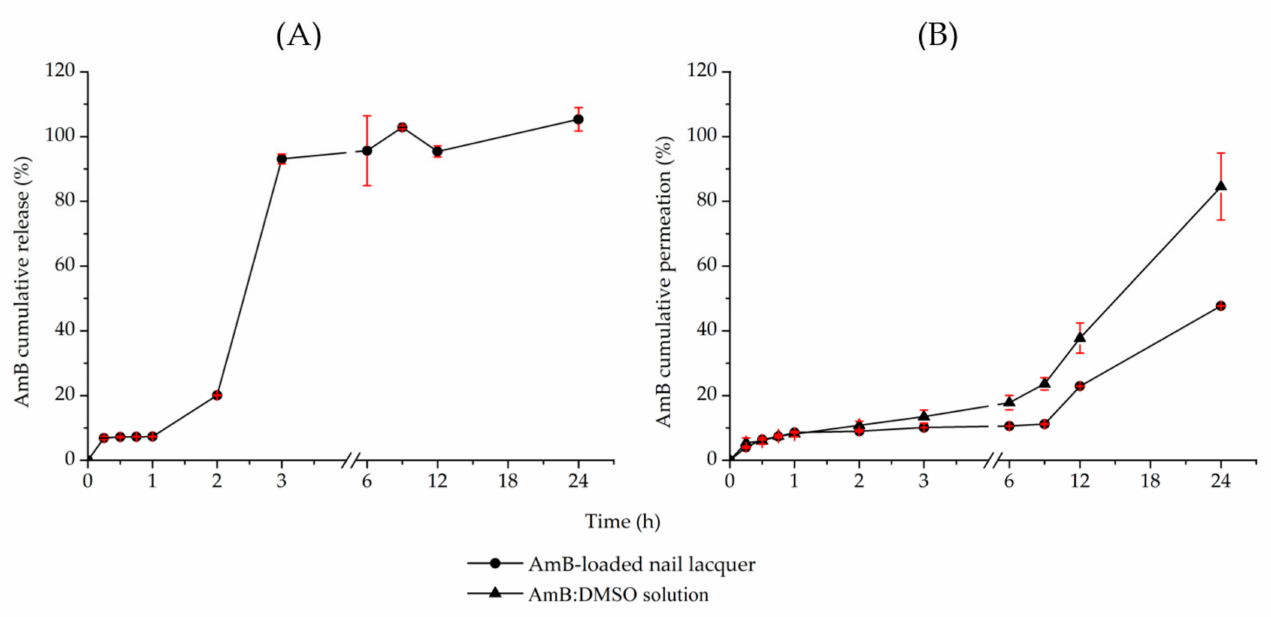
Figure 3. AmB in vitro release and ex vivo permeation profiles from AmB-loaded nail lacquer. ( A ) AmB’s cumulative release percentage in phosphate saline buffer medium. ( B ) AmB’s cumulative permeation percentage across an ex vivo nail model from bovine